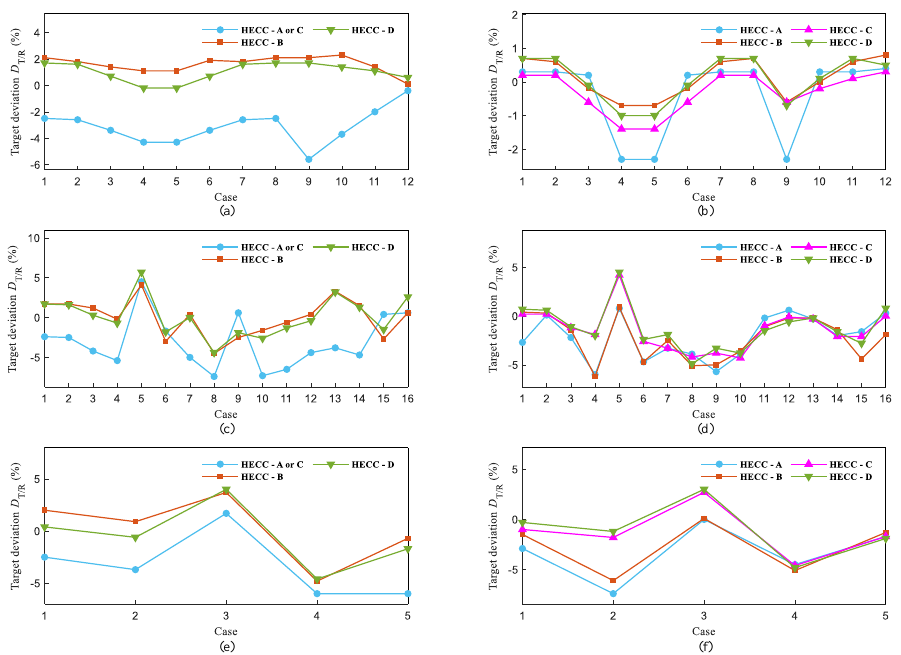
Figure 5. By adopting the accuracy measure, the target deviations for cases in three types of numerical experiments were as shown above; ( a , b ) contains cases for the first type without and with maximum area limitations; ( c , d ) contains cases for the second type without and with maximum area limitations; ( e , f ) contains cases for the third type without and with maximum area limitations.